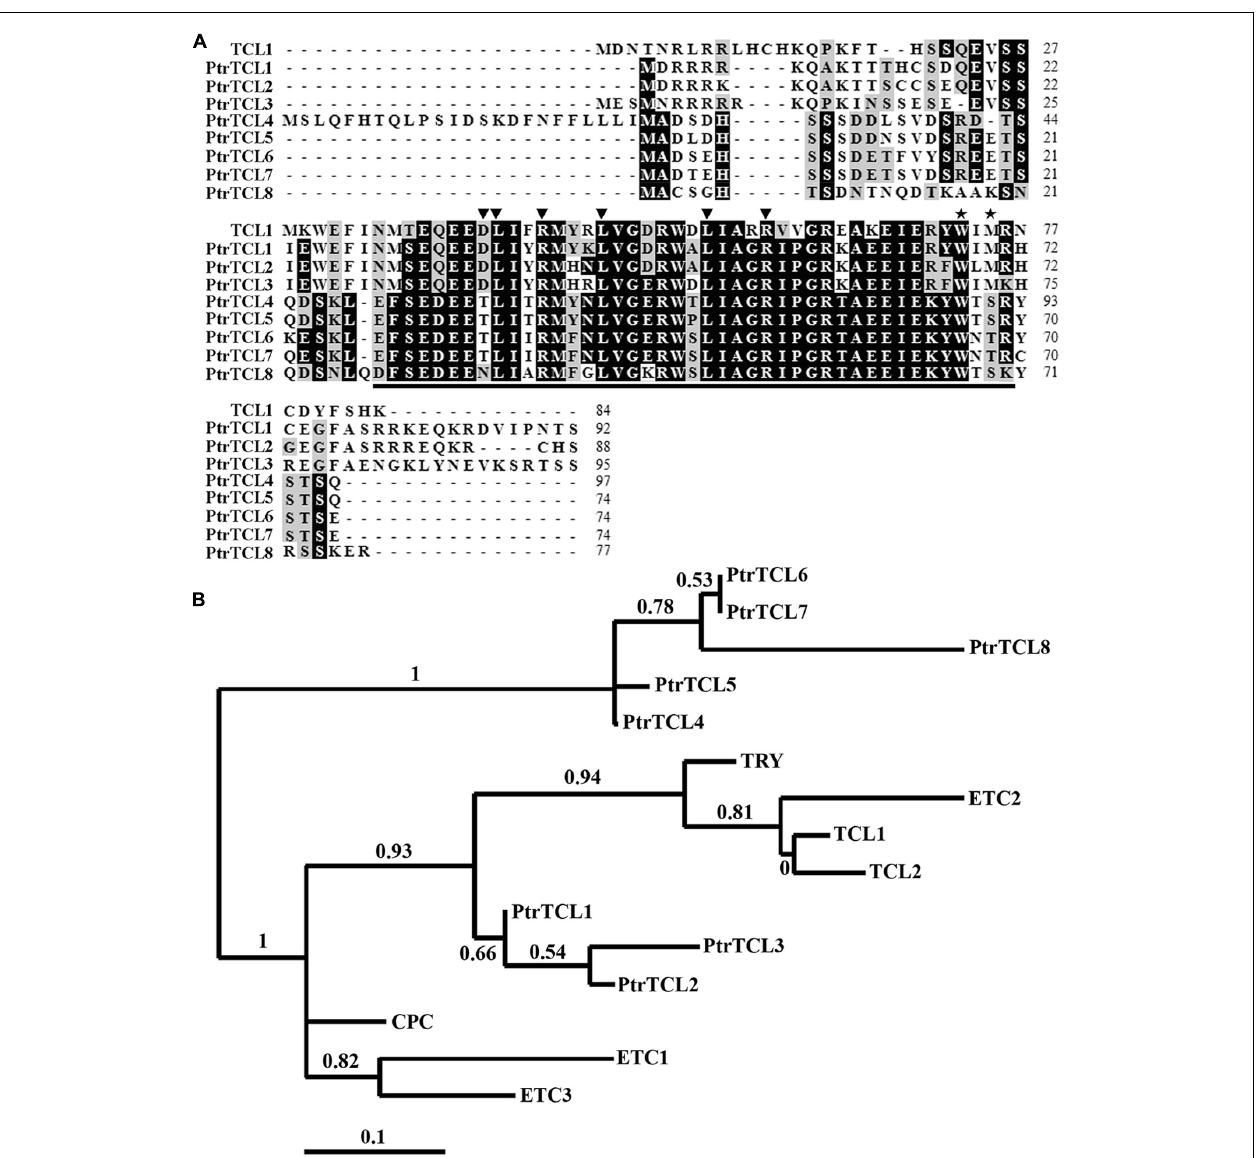
are crucial for cell-to-cell movement of CPC are indicated by asterisks. (B) Phylogenetic analysis of seven Arabidopsis and the eight poplar R3 MYB transcription factors.The entire amino acid sequences were used to generate the phylogenetic tree by using “One Click” mode of Phylogeny (www.phylogeny.fr) with default settings. Branch support values are indicated above or below branches, bar indicates branch